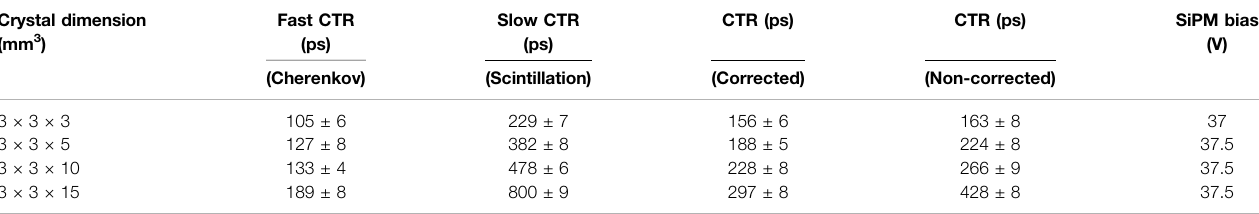
TABLE 3 | Best FWHM CTR values obtained for each different crystal length before and after corrections. The second and third columns report the CRT values when only considering the fast (Cherenkov contribution) or slow (Scintillation contribution) component of the timing signal. Crystal dimension (mm 3